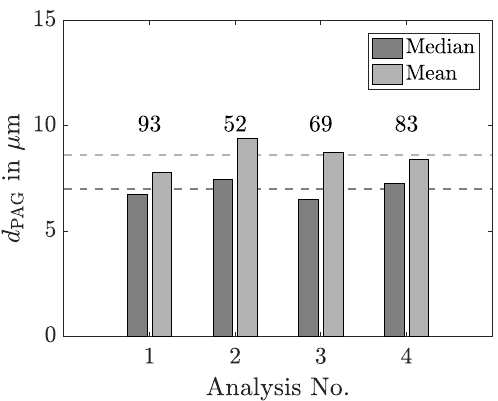
Figure 6. Comparison of mean and median prior austenite grain cross-section areas in the measured EBSD domain; numbers above bars indicate the number of evaluable grains in the domain.